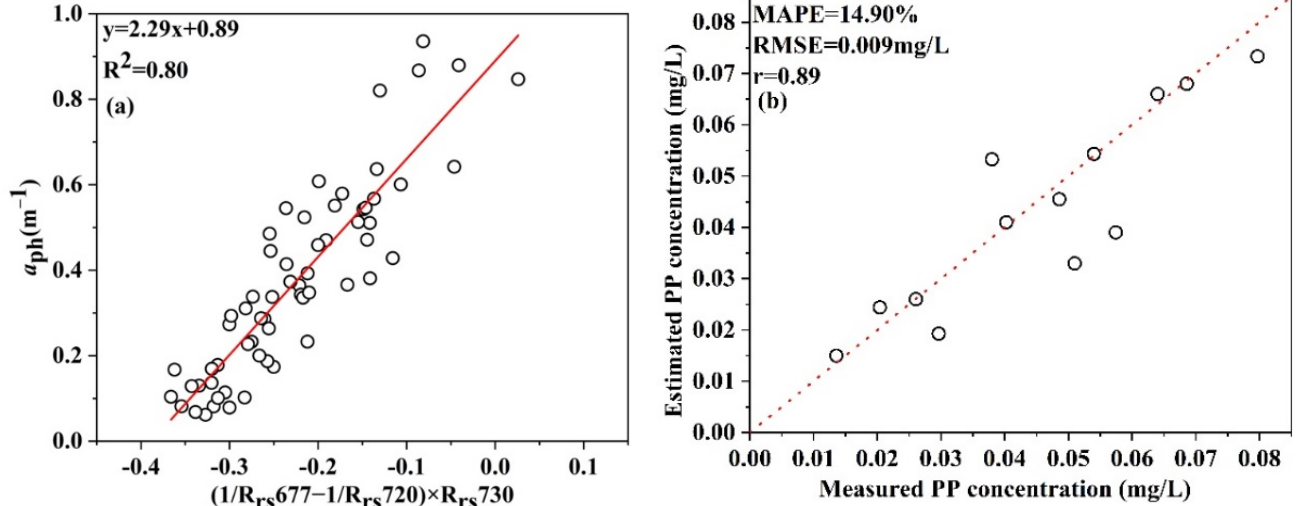
Figure 4. ( a ) The a ph and R rs fitting curve at 677 nm; ( b ) comparison between the measured PP values and those estimated based on measured hyperspectral data.